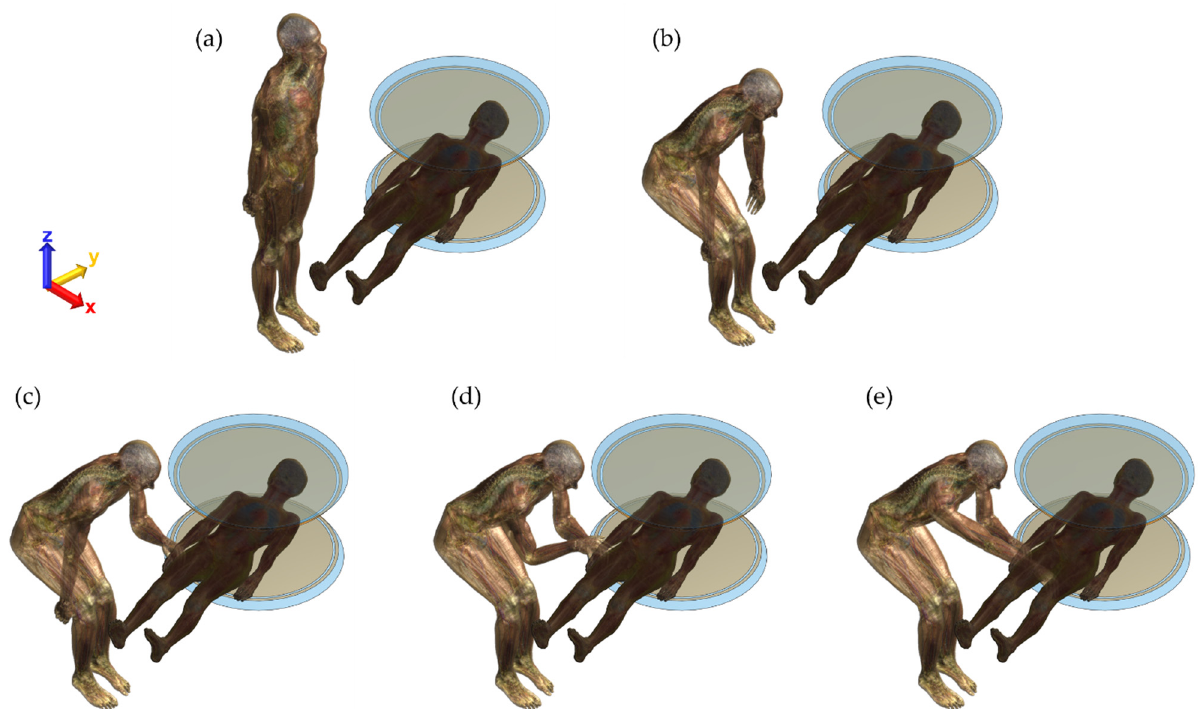
Figure 3. Various poses of patient assistant and the corresponding RF exposure; ( a ) Pose 1: standing; ( b ) Pose 2: sitting next to a patient; ( c ) Pose 3: touching a patient’s hand with one hand of patient assistant; ( d ) Pose 4: two hands stacked up; and finally, ( e ) Pose 5: patient’s hand and thigh touched with two hands.